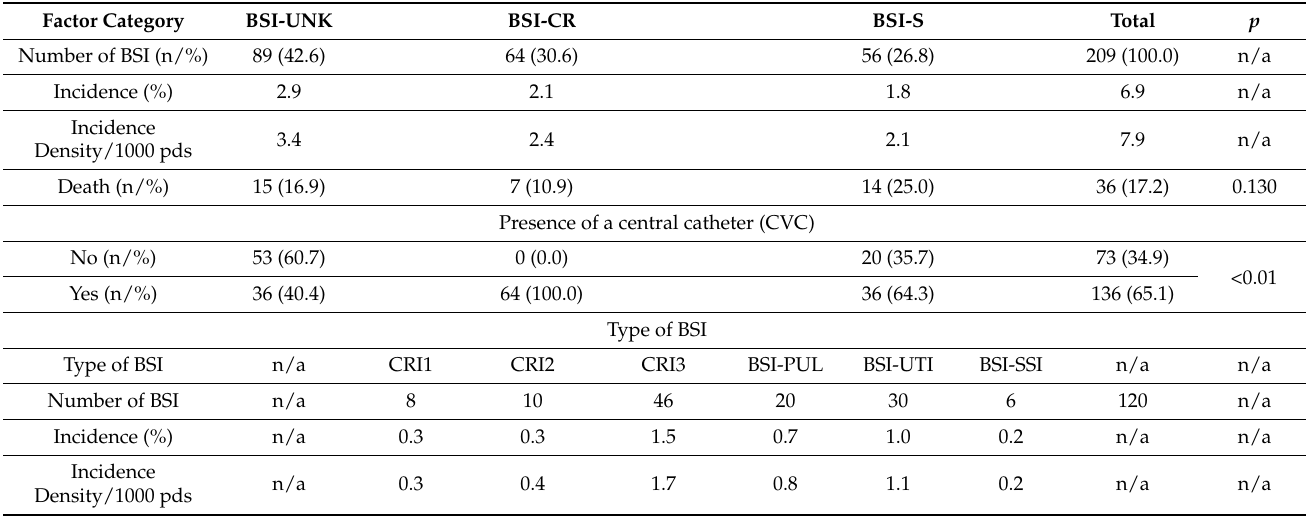
Table 2. Clinical forms of BSI, frequency of occurrence, incidence, incidence density, presence of a central catheter, mortality in ICUs in 2016–2019.